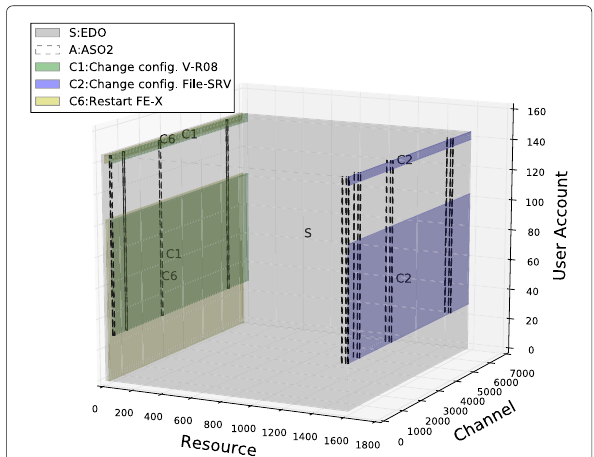
Fig. 3 Graphical representation of threat AS 02 ( dashed ) and a corresponding response plan composed of three mitigation actions ( C 1 yellow , C 6 green , and C 2 blue , from left to right). The graybox represents the full operational dimension of the